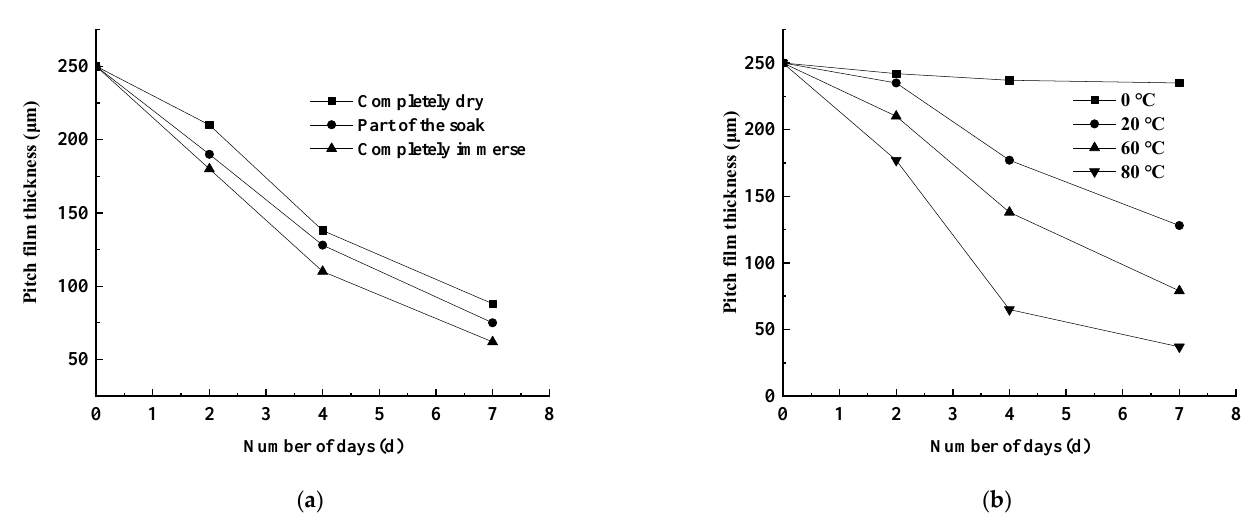
Figure 6. Asphalt film thickness under different test conditions: ( a ) asphalt film thickness under different humidity levels; ( b ) asphalt film thickness at different temperatures.